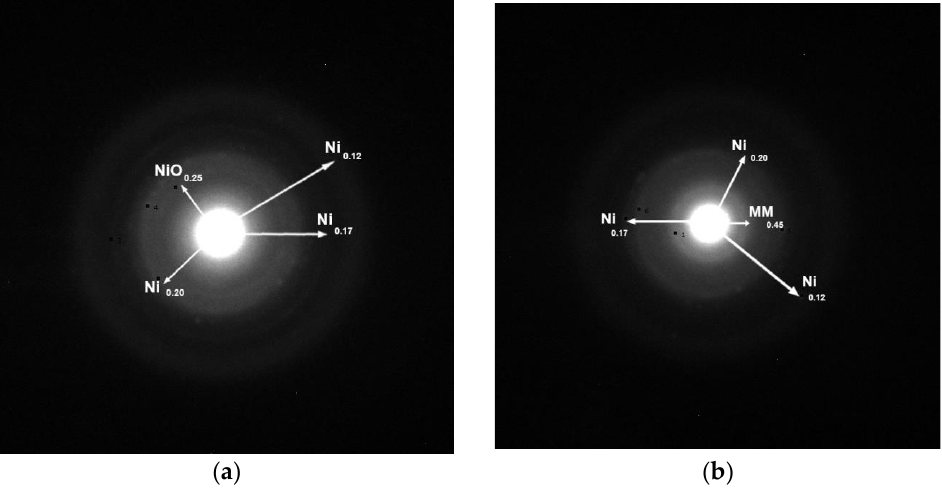
Figure 5. Typical electron diffraction patterns of the samples ( a ) 20Ni/MM(H) and ( b )